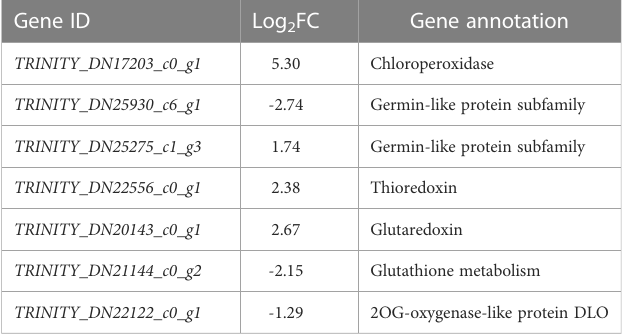
TABLE 3 Differentially expressed genes related to antioxidant